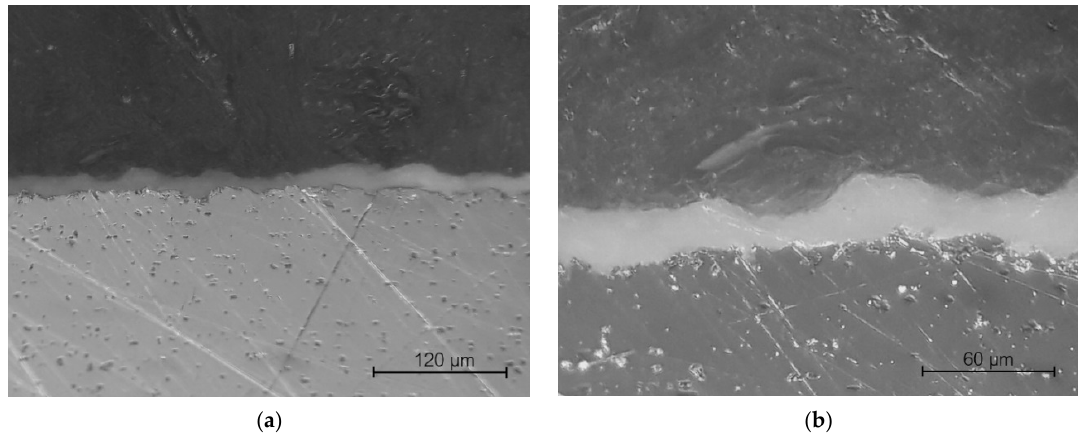
Figure 6. Microscopic images of untested specimen cross section showing the thickness of paint layers at different magnifications: ( a ) layer view with a magnification of 20 × ; ( b ) layer view with a magnification of 40 × .